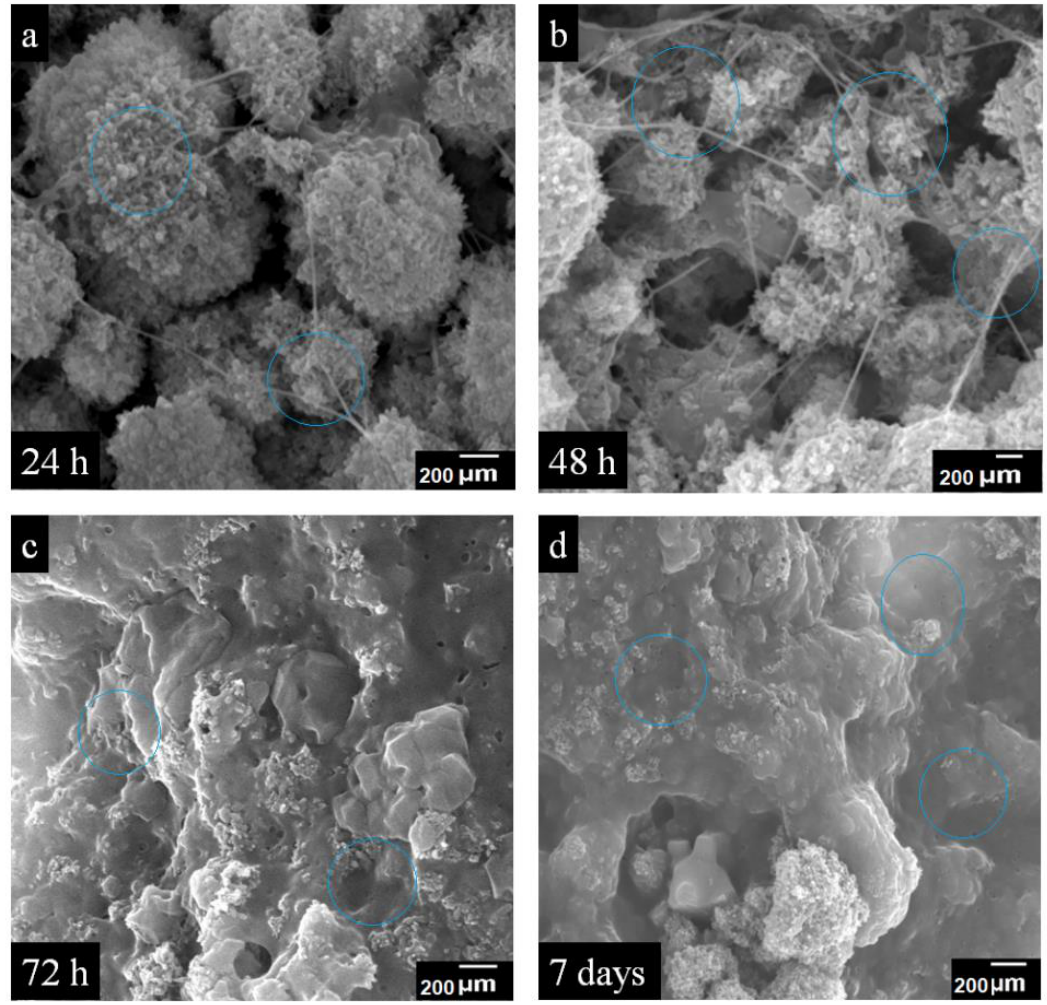
Figure 10. SEM images of pre-osteoblast over BNS3 after: ( a ) 24 h, ( b ) 48 h, ( c ) 72 h, and ( d ) 7 days of cell growth.